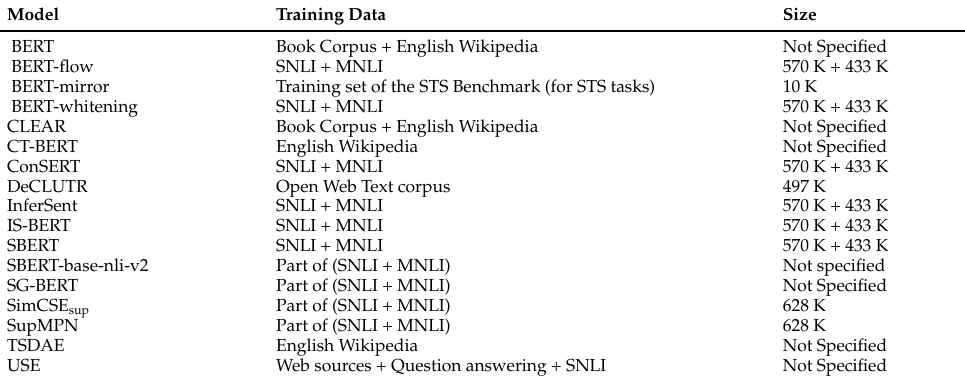
Table A2. Training data and their sizes in SupMPN and other